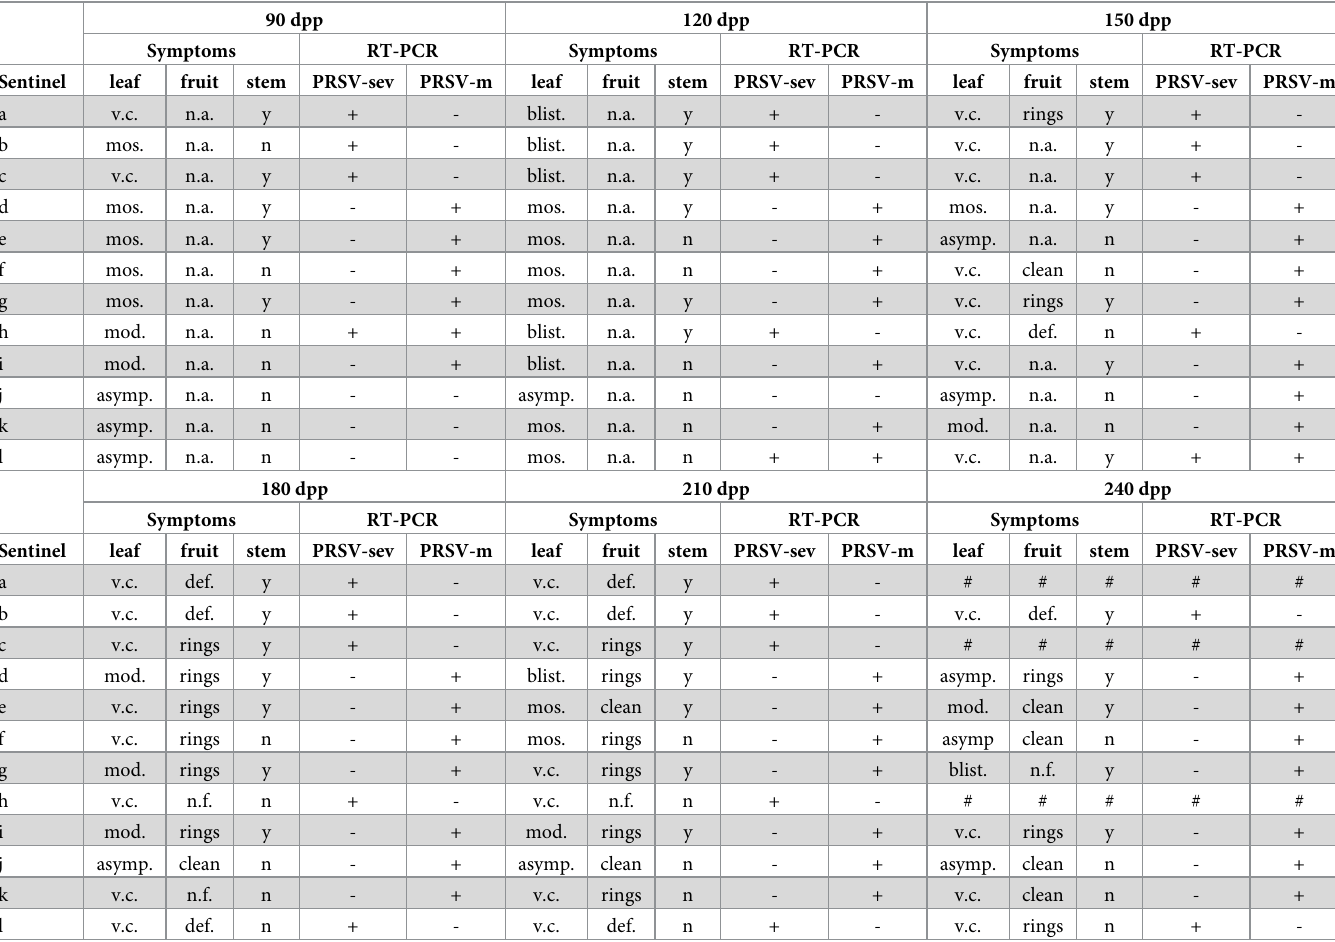
Table 2. Dynamics of the mild and severe isolate of papaya ringspot virus (PRSV-mild and PRSV-sev) under field